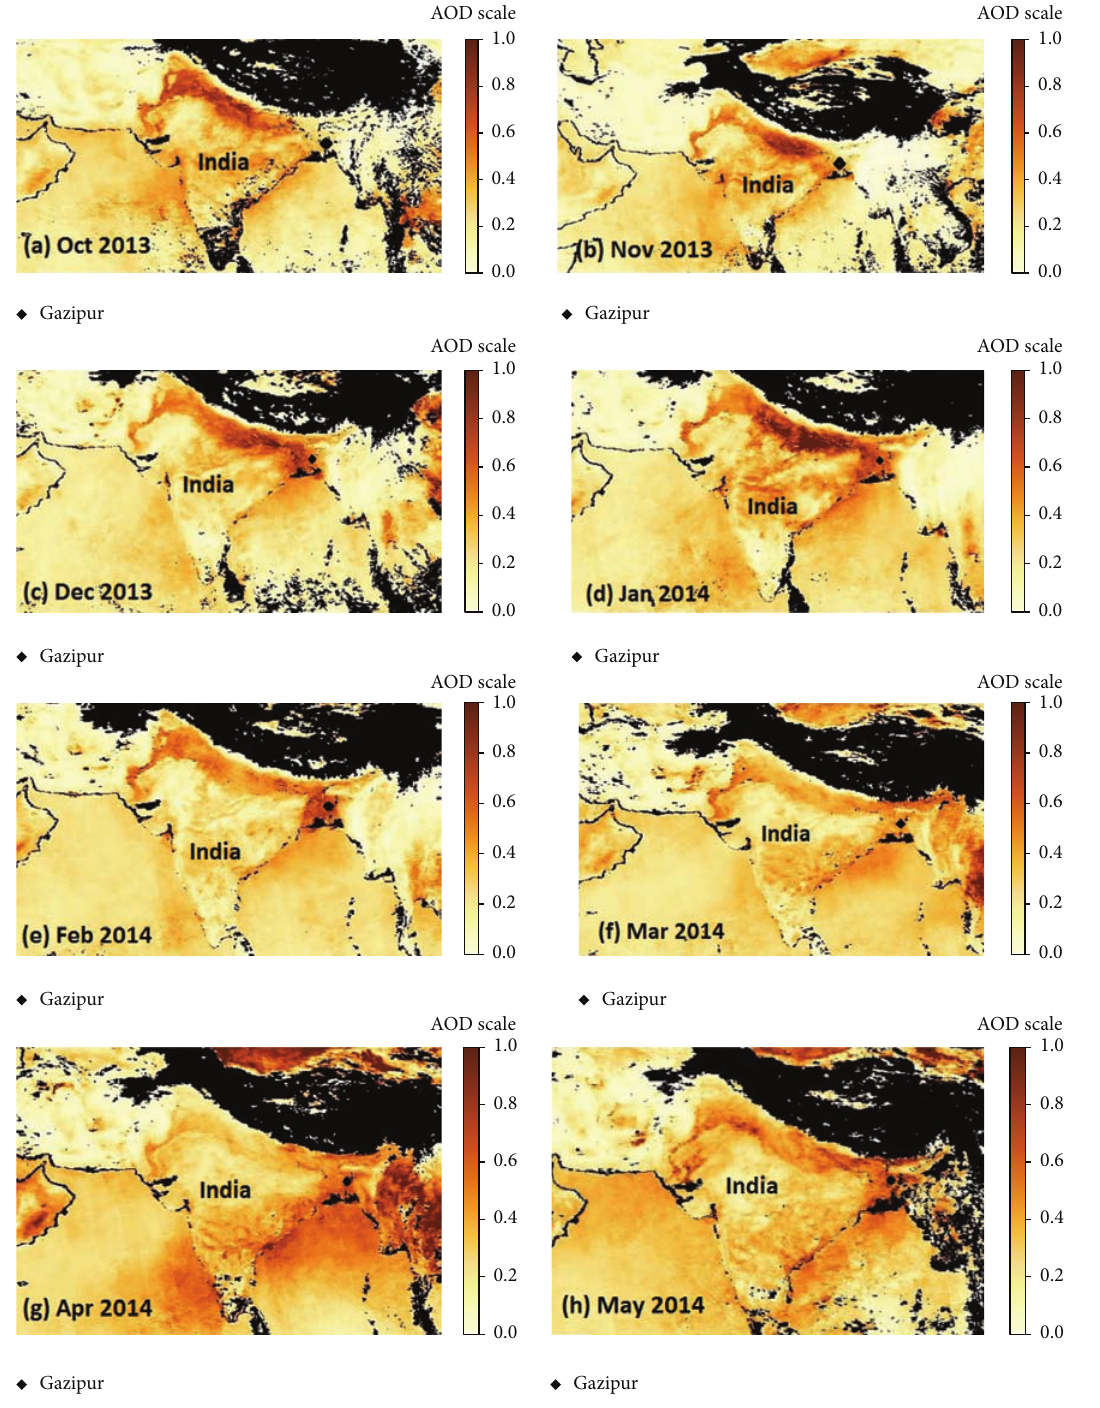
Figure 10: Monthly average AOD on South Asia captured by MODIS aboard Terra of NASA.